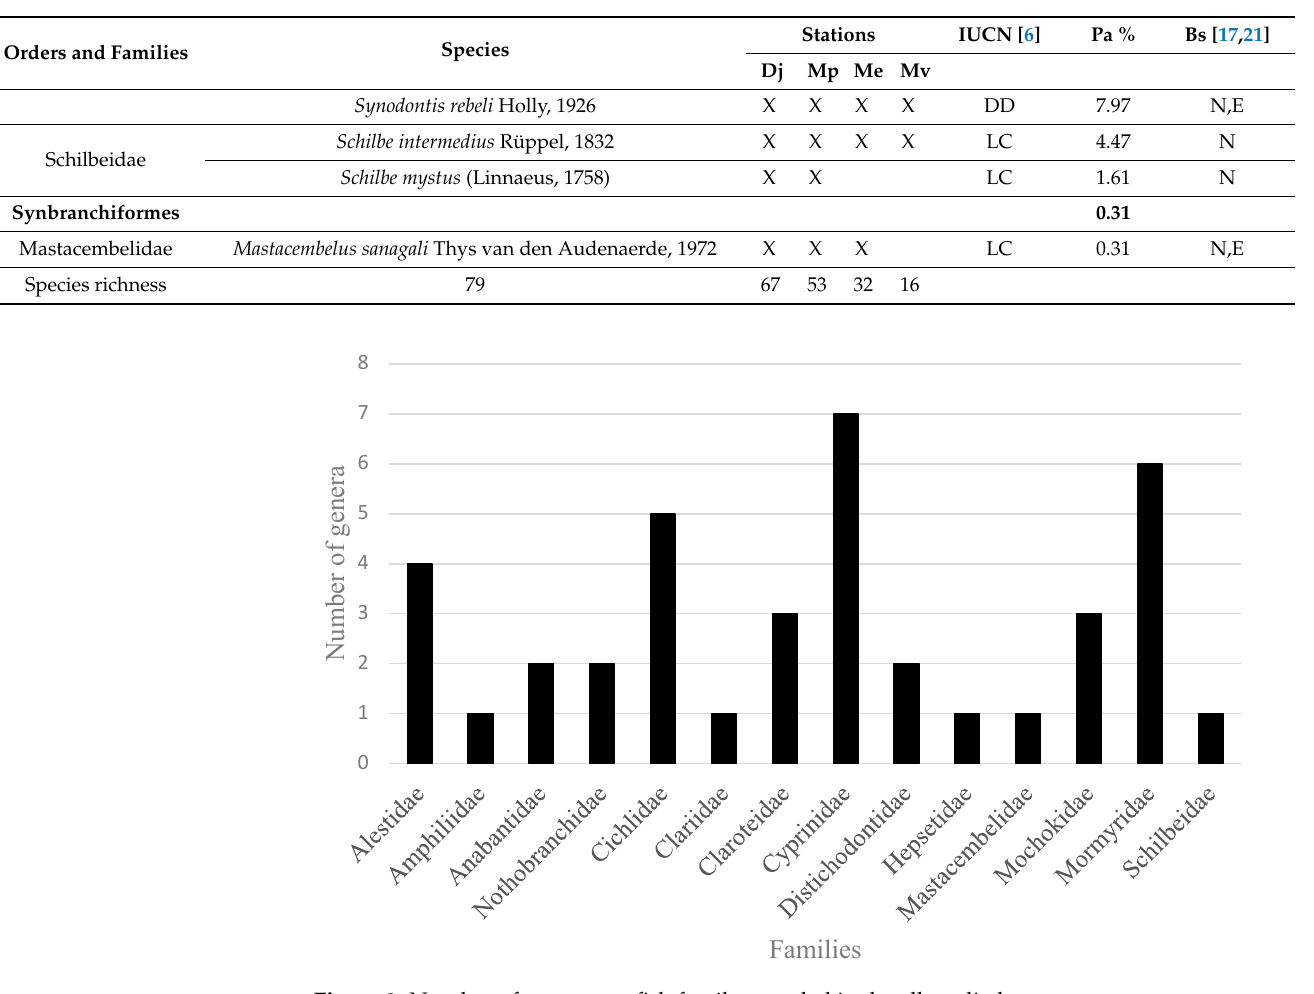
Table 3. List of fish taxa inventoried in the MpDNP: Dj = Djim River, Mp = Mpem River, Me = Mey River, Mv = Mvouring River; IUCN status: LC = Least Concern, VU = Vulnerable, NE = Not Evalu- ated, EN = Endangered, DD = Data Deficient; presence (X) or absence (empty); E = endemic (to the Sanaga River basin), N = native (indigenous to the Sanaga River basin, but present elsewhere as well); I = introduced (and non-native to the Sanaga River basin); Pa = percentage abundance; Bs = Biogeographic status.